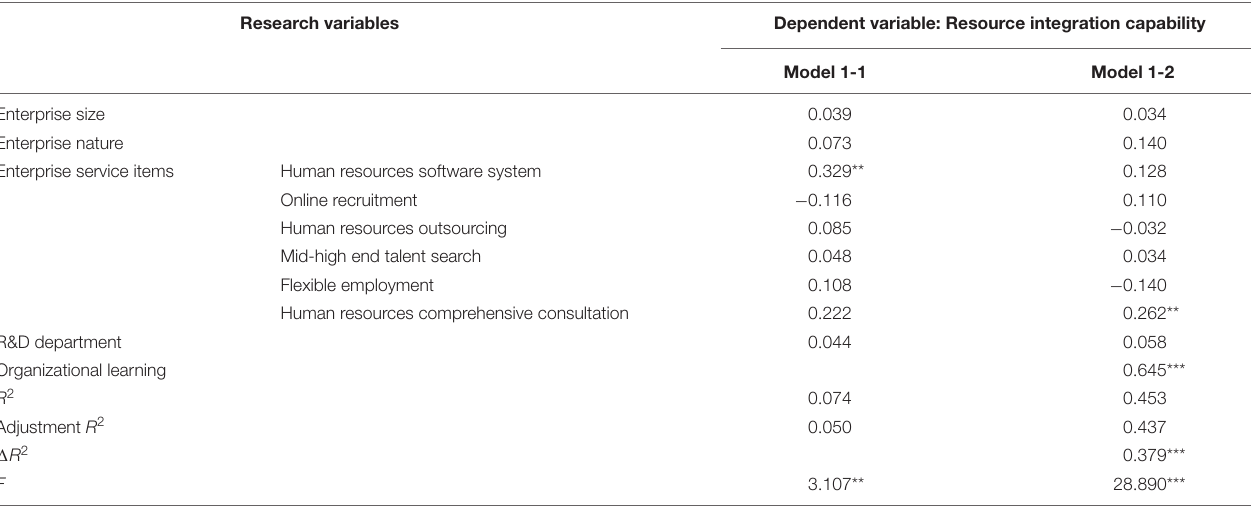
TABLE 5 | Regression analysis results of organizational learning on resource integration